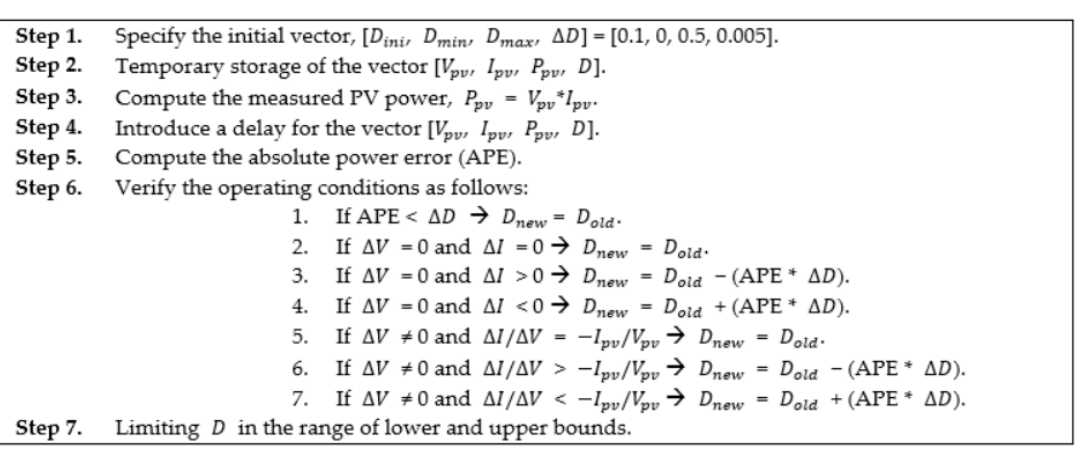
Figure 4. Power and control diagram of a photovoltaic generator (PVG) connected to a boost converter.